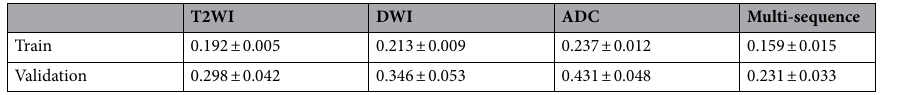
Table 1. Dice losses for the models with each MRI sequence as the input data for five-fold cross-validation. Data are presented as the mean and standard deviation of five cross-validation models. Train : train loss, Validation : validation loss, ADC : apparent diffusion coefficient map, DWI : diffusion-weighted image, T2WI : T2-weighted image.